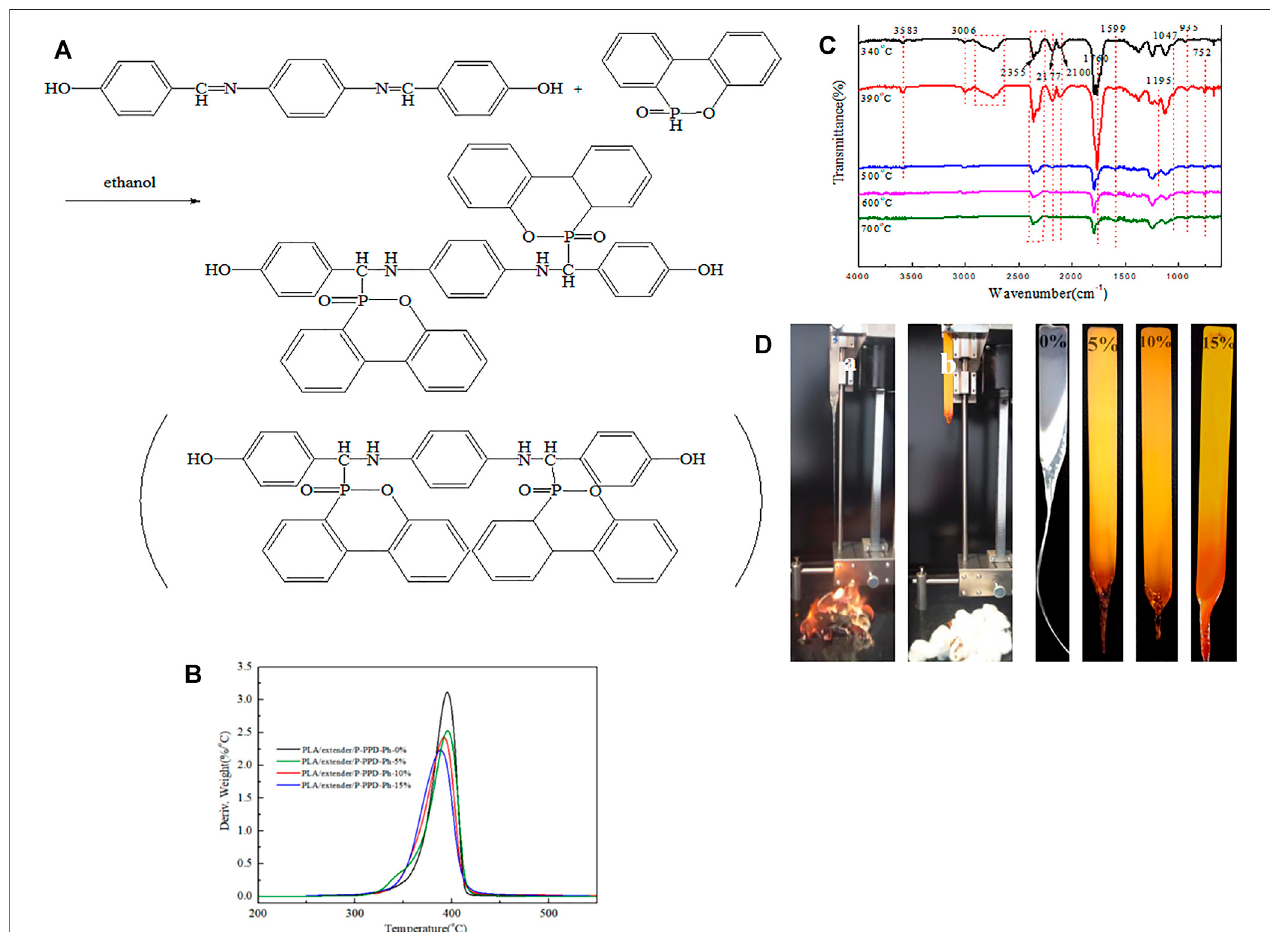
FIGURE 1 | (A) Schematic diagram of synthetic P-PPD-Ph. (B) Thermal analysis of PLA and PLA-conjugated fl ame-retardant composites under nitrogen (N 2 ) atmosphere. (C) FTIR spectra of the PLA-conjugated fl ame-retardant composites at different temperatures of TG under N 2 atmosphere. (D) Photos of samples during the UL-94 test (a is PLA/P-PPD-Ph-0%, and b is